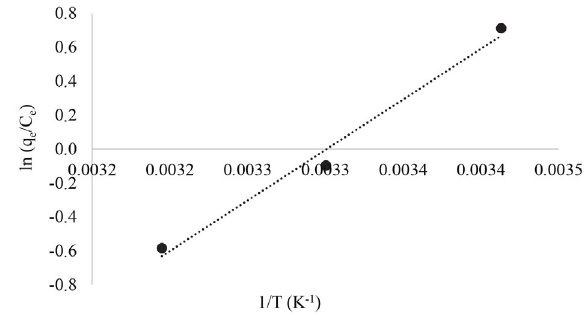
Figure 7. van’t Hoff plot for the biosorption of RBV-5R dye, where slope (-ΔH°/R) = 5952, intercept(ΔS°/R) = -19.65 and R 2 -coefficient = 0.985.